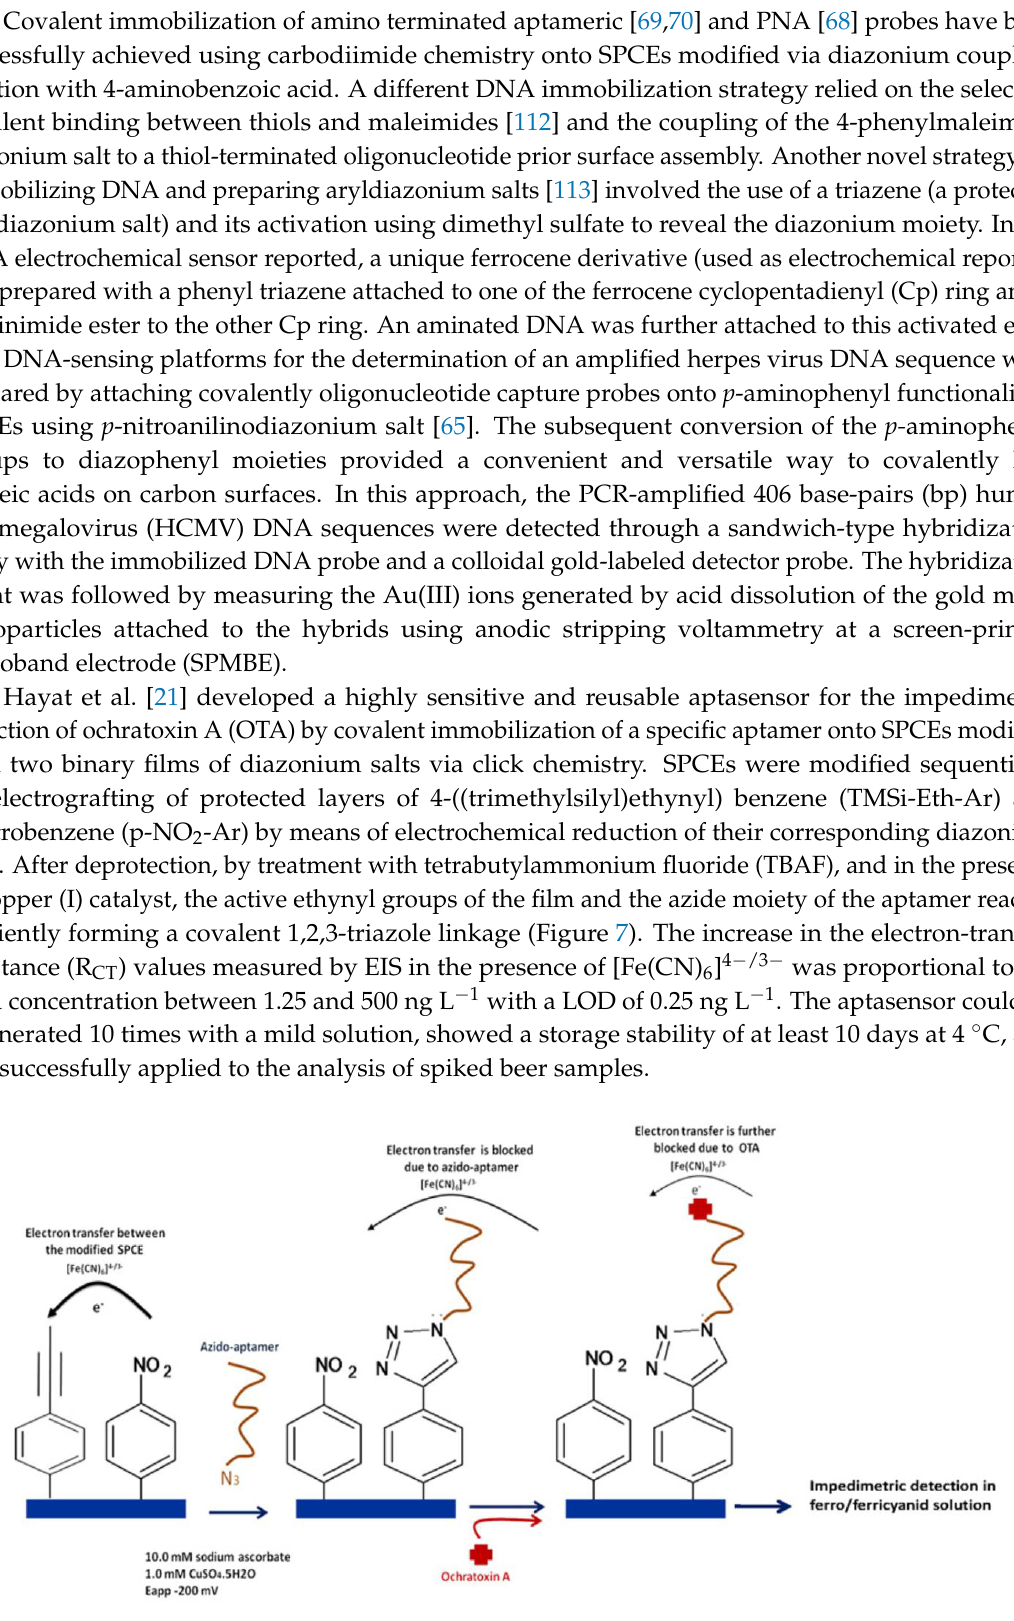
Figure 7. Schematic display of the working principle of the impedimetric aptasensor for the determination of OTA. Reprinted from [21] with permission.